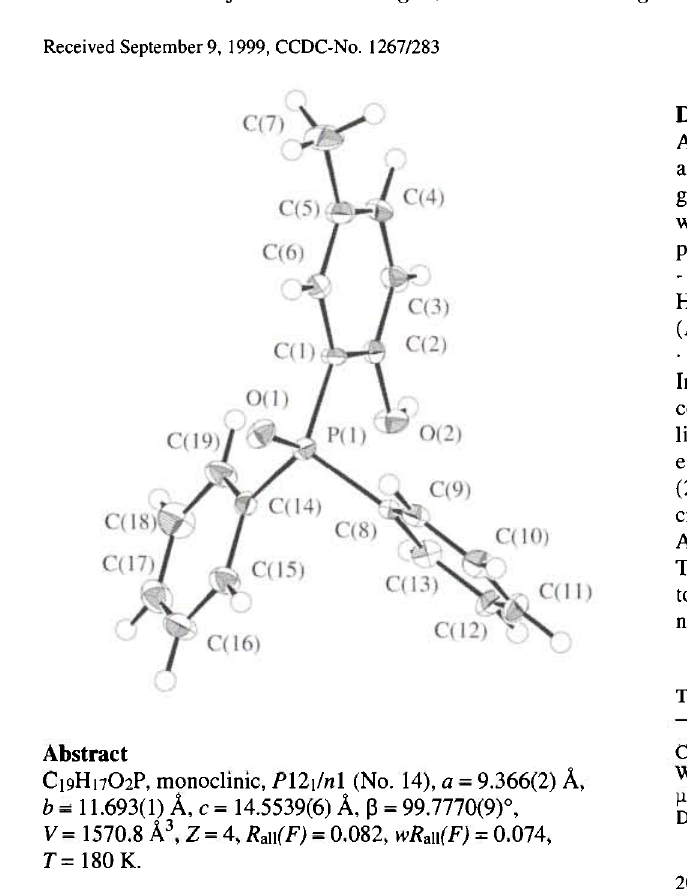
Table 1. Data collection and handling.